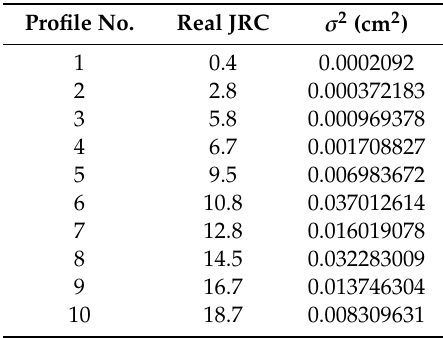
Table 1. The point-variance of the ten standard profiles along with their actual joint roughness coe ffi cient (JRC) coe ffi cients. Profile